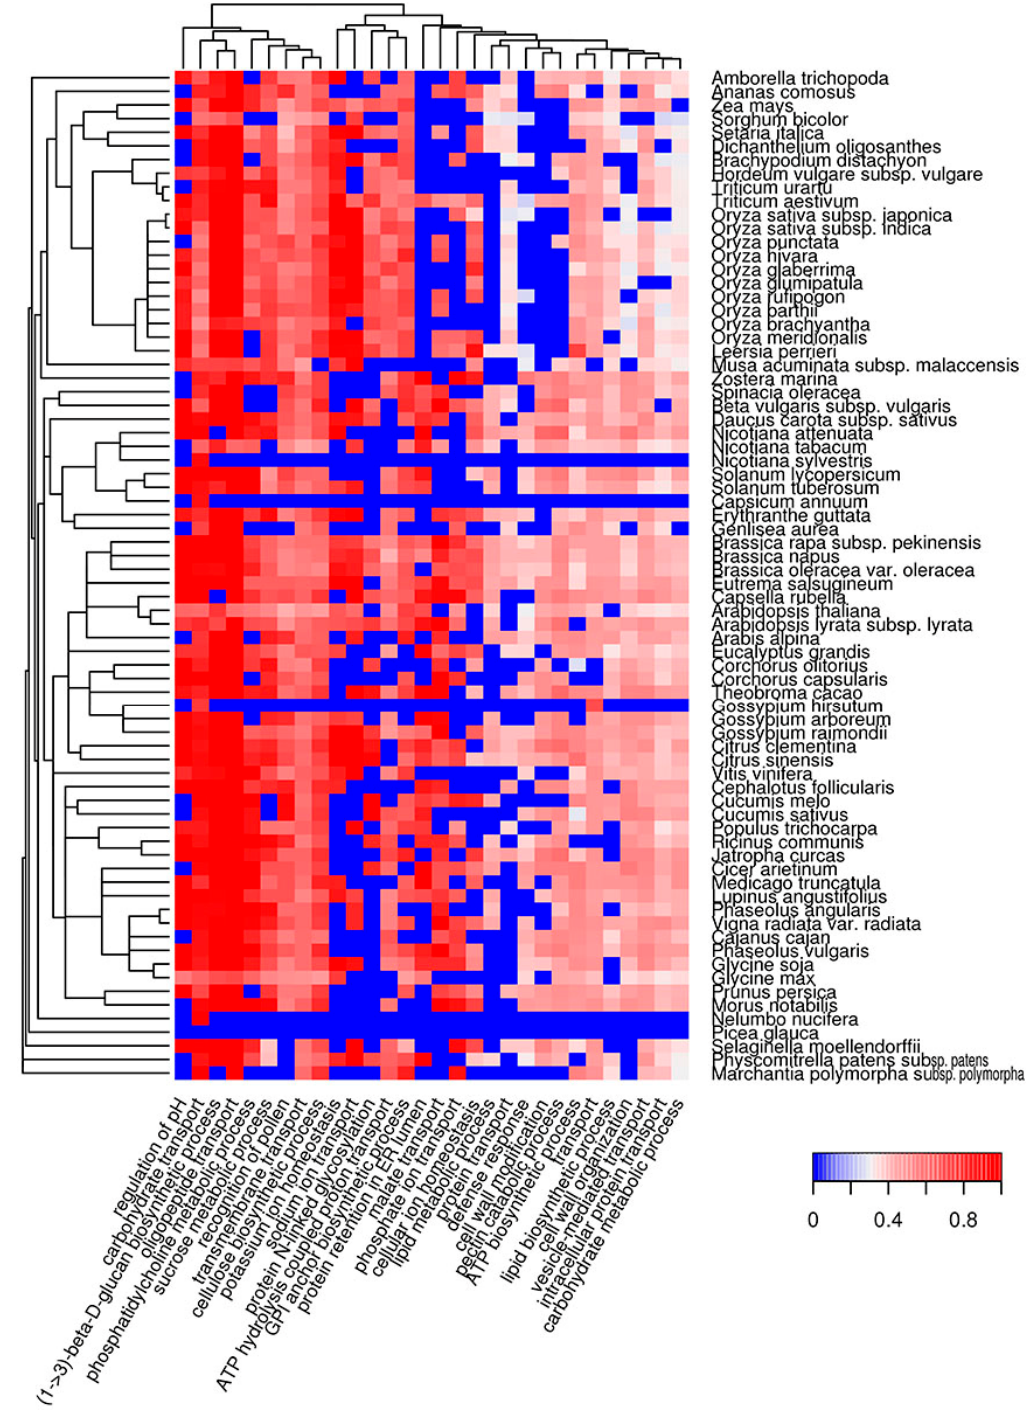
Figure 4. Heat map of GO biological processes in which potentially amyloidogenic proteins predicted by Waltz are overrepresented. For such proteins, the top 30 GO terms from the molecular function ontology are shown. The color of the cells denotes the fraction of potentially amyloidogenic proteins predicted by Waltz among all proteins annotated with this term. All cells with p -values greater than 0.01 have values of 0 ( dark blue ). The dendrogram of plant species corresponds to their phylogenetic tree.